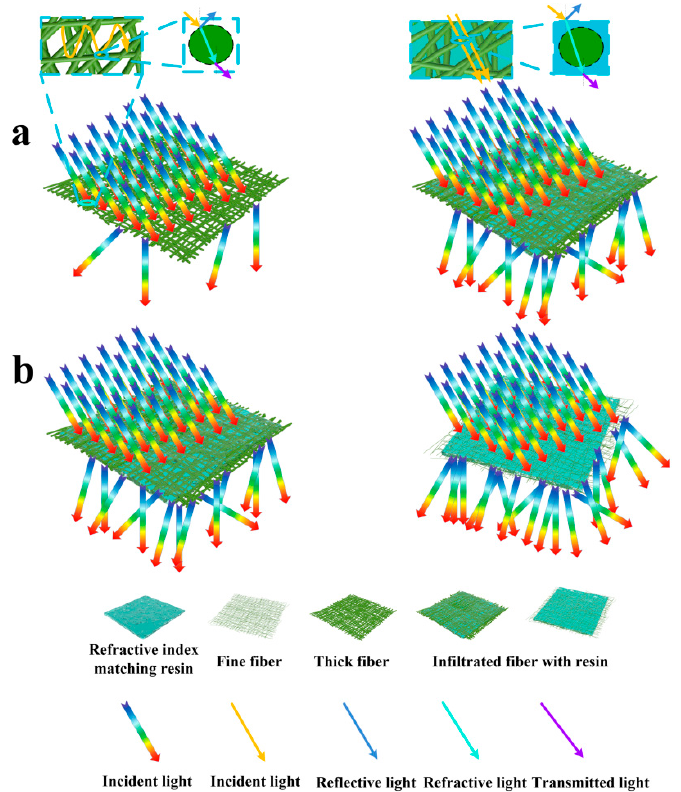
Figure 4. Schematic diagram of the influence of refractive index, ( a ) electrospun fibers diameter and ( b ) refractive index on light propagation (the number of arrows represents light intensity).